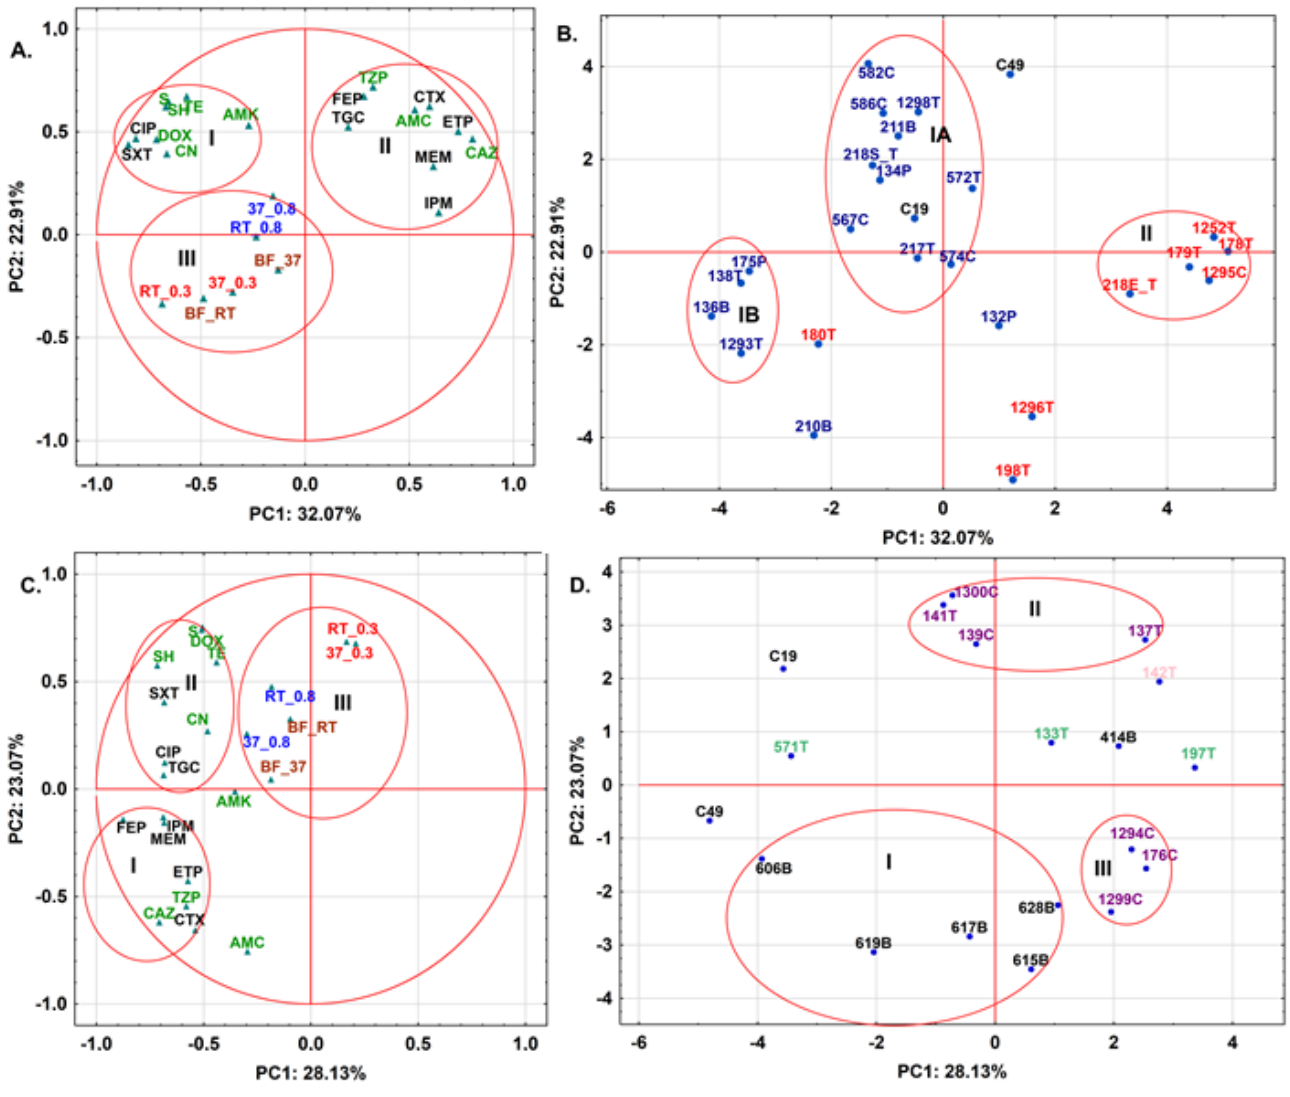
Figure 5. The PCA results for variables ( A , C ) and objects (OTUs) ( B , D ) based on data for antibiotic resistance (excluding ampicillin (AMP) and cefuroxime (CXM)) and phenotypic tests (swimming, swarming and biofilm formation) for tested cephalosporine-resistant strains ( E. coli and S.